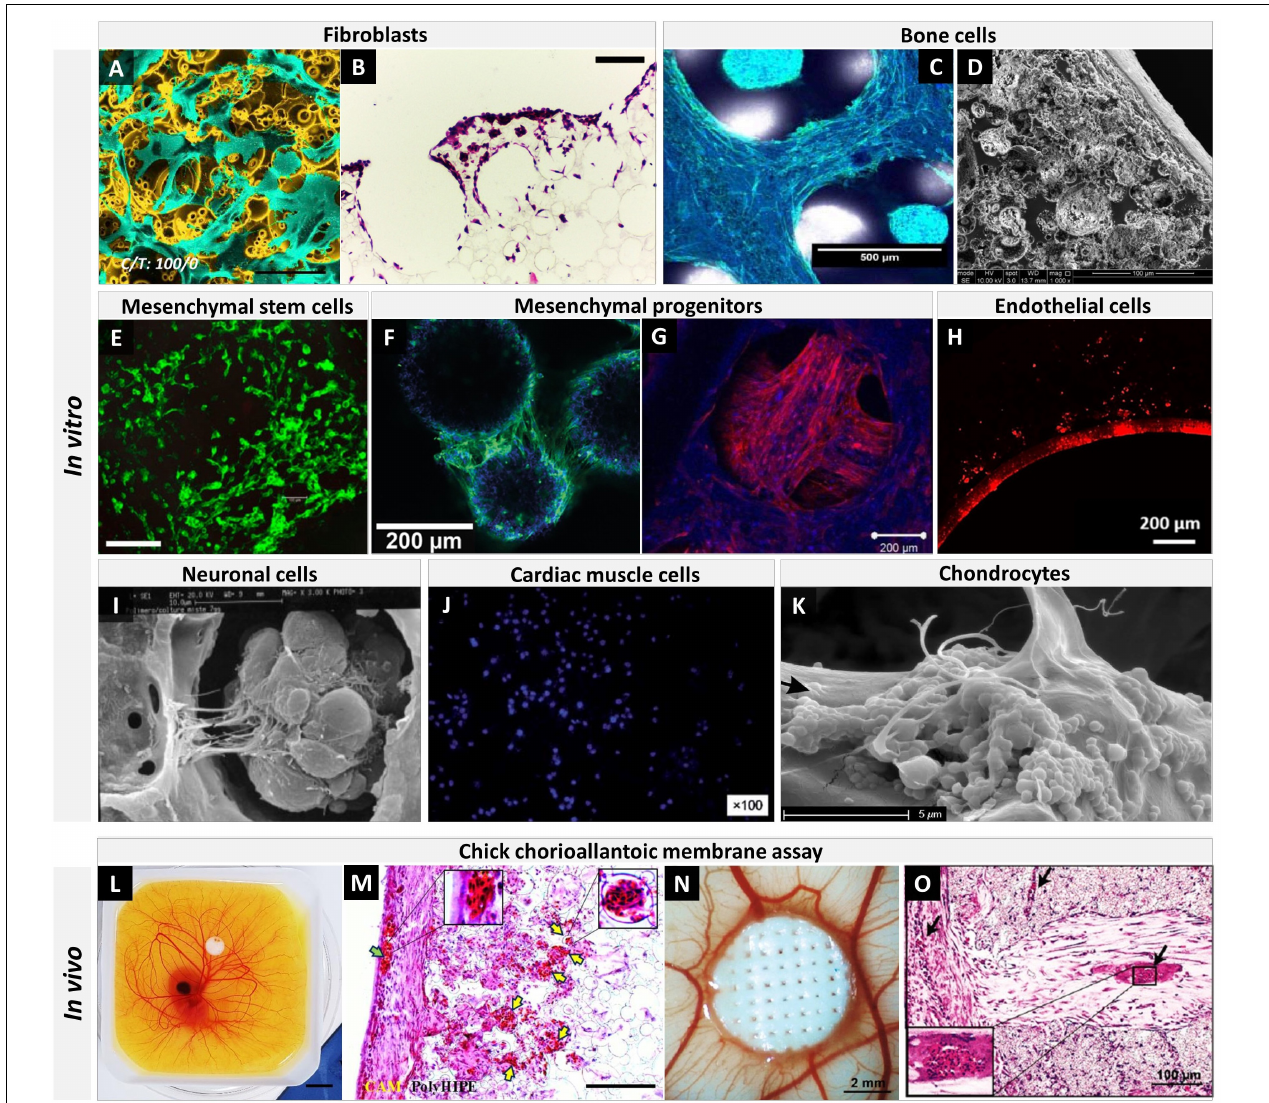
FIGURE 13 | Tissue engineering applications of emulsion templated scaffolds. (A) False coloured scanning electron microscopy (SEM) image of human dermal fibroblasts on PCL PolyHIPE (Aldemir Dikici et al., 2019b) (scale bar: 250 µ m), (B) H&E image of L929 fibroblasts on thiolene PolyHIPE (Johnson et al., 2015)